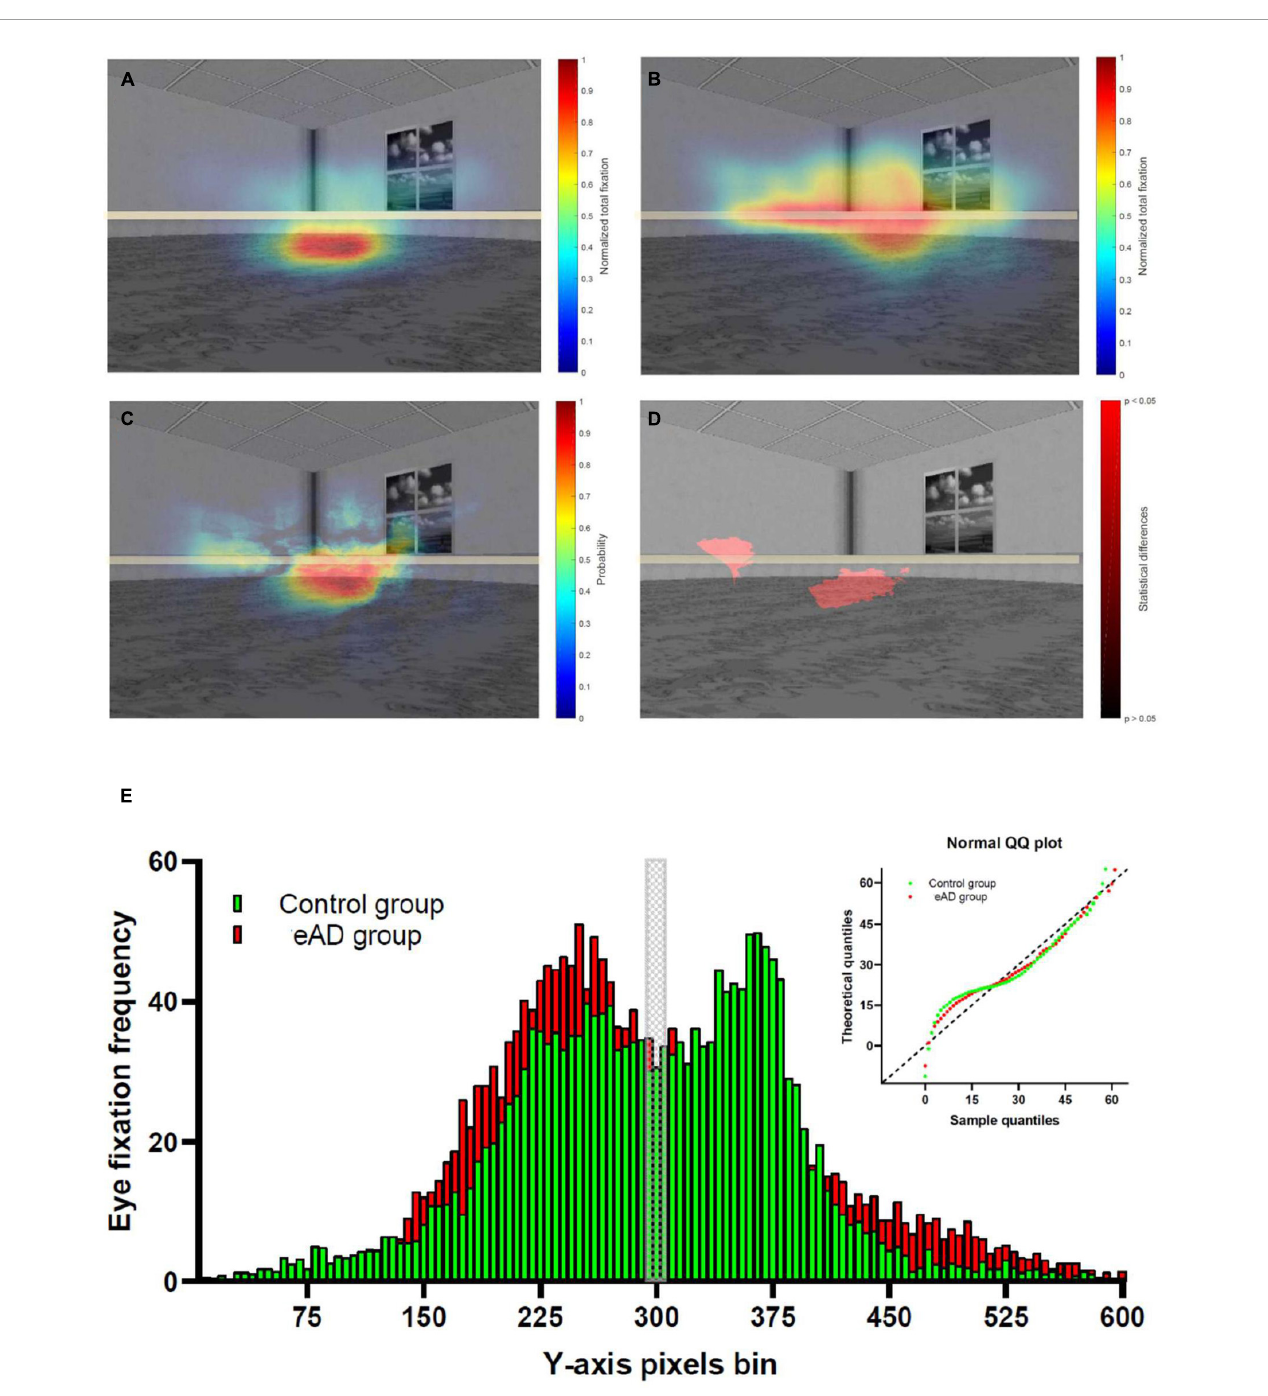
FIGURE2 Heat map of the spatial distribution of eye-fixation of the control and early Alzheimer’s disease (eAD) group. (A) Heat map of eye-fixation of the control group, with high fixation density in the center. (B) Heat map of eye fixation of the eAD group demonstrated a less localized exploration. Warmer colors represent a higher number of fixations. (C) Heat map of the probability differences in the visual exploration. Warmer colors represent a higher probability and in panel (D) regions with statistical differences in visual exploration between control and eAD group. The red path represents statistical differences (Wilcoxon rank-sum test, p < 0.05). The horizontal gray line represents the central region of the image. (E) Comparison eye fixation frequency distribution in Y -axis pixels bin between control and eAD group, Kolmogorov–Smirnov test comparison cumulative fixation fraction (K–S test; D = 0.11, p = 0.0014). The gray block represents the central region of the image, while control group and eAD group results are represented in green and red,